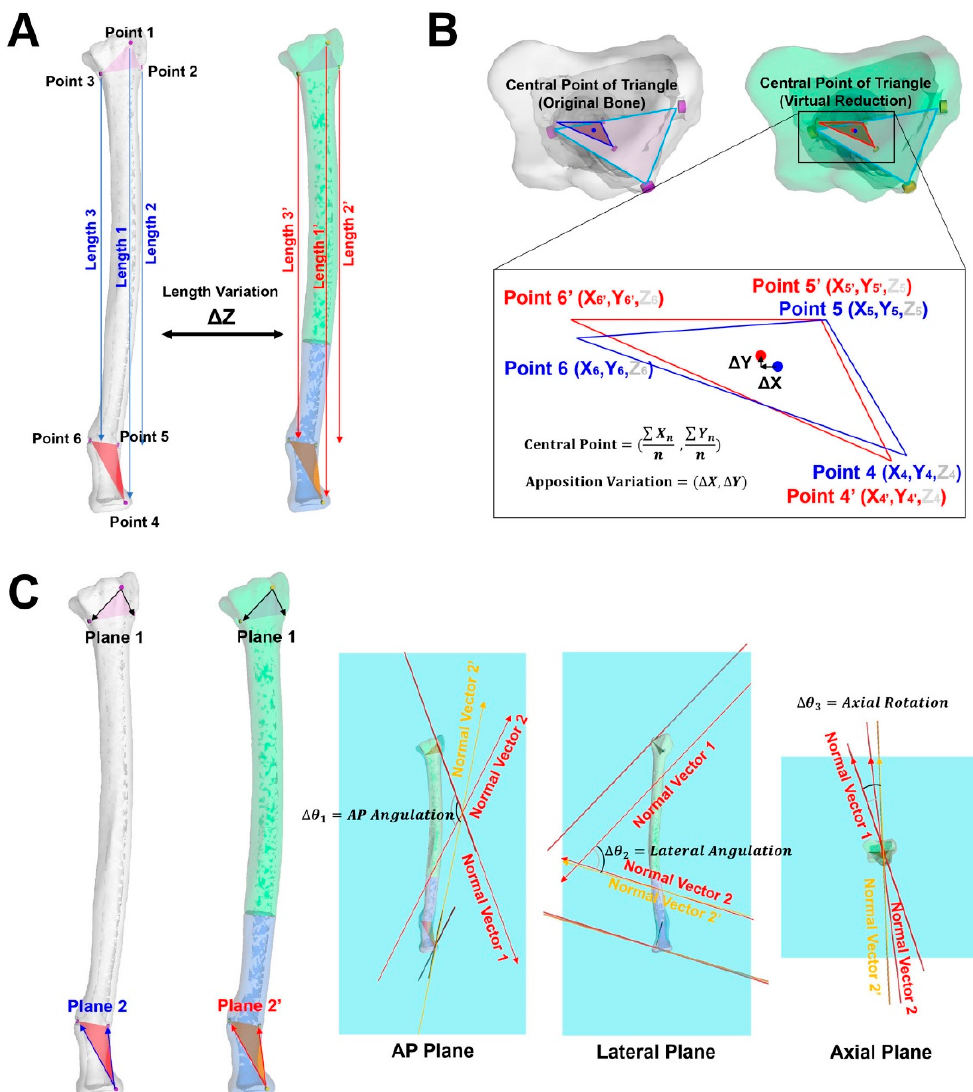
Figure 3. 3D-based method of accuracy evaluation for virtual reduction. ( A ) There were three cortical marking holes on the distal part and three points on the proximal part. The three original lengths only in the Z-axis were measured as Length 1 (between Point 1 and Point 4), Length 2 (between Point 2 and Point 5) and Length 3 (between Point 3 and Point 6). The length variation was calculated using the change in length (Length 1 ′ , Length 2 ′ , and Length 3 ′ ). ( B ) When the 2D sky blue color triangles for both the original object and the virtually reduced object were fixed at the same position, the location of the deep 2D blue triangle belonging to the original object was converted to the location of the 2D red triangle in the virtually reduced object. The variation of apposition was calculated by measuring the variation of the X and Y coordinates from the central point of the triangles (from deep blue to red) ( C ) The three marking holes on the distal part generated Normal Vector 1 via Plane 1, and the other three marking holes on the proximal part generated Normal Vector 2 via Plane 2 (from original object), and Normal Vector 2 ′ via Plane 2 ′ (from the virtually reduced object). AP angulation and Lateral angulation indicate the difference in the angle between Normal Vector 2 and Normal Vector 2 ′ on the AP plane and the lateral plane, respectively. The angle difference in the rotation was measured by the variation in the angle between Normal Vector 2 and Normal Vector 2 ′ on the axial plane. Although the third and last evaluation corresponded to the measurements of alignment and rotation, respectively, both evaluations are performed at once using 3D